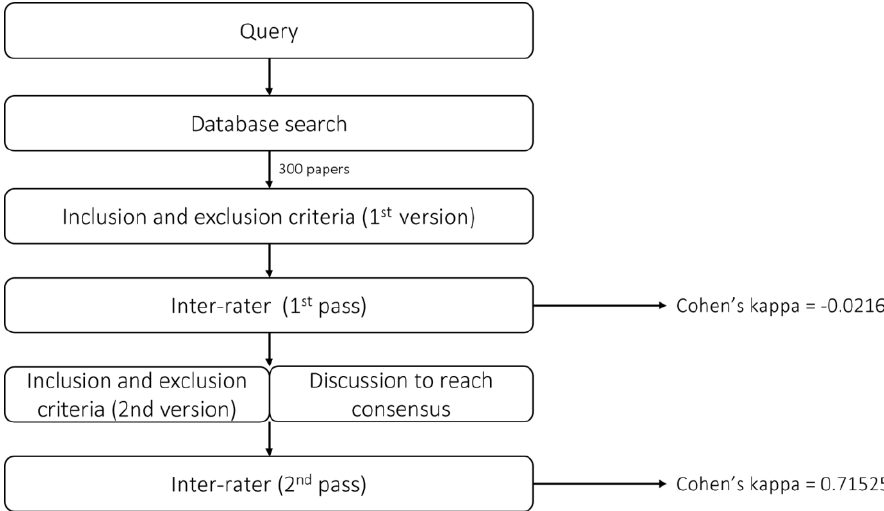
Figure 3. Diagram of the literature review process for the EXAI dataset.